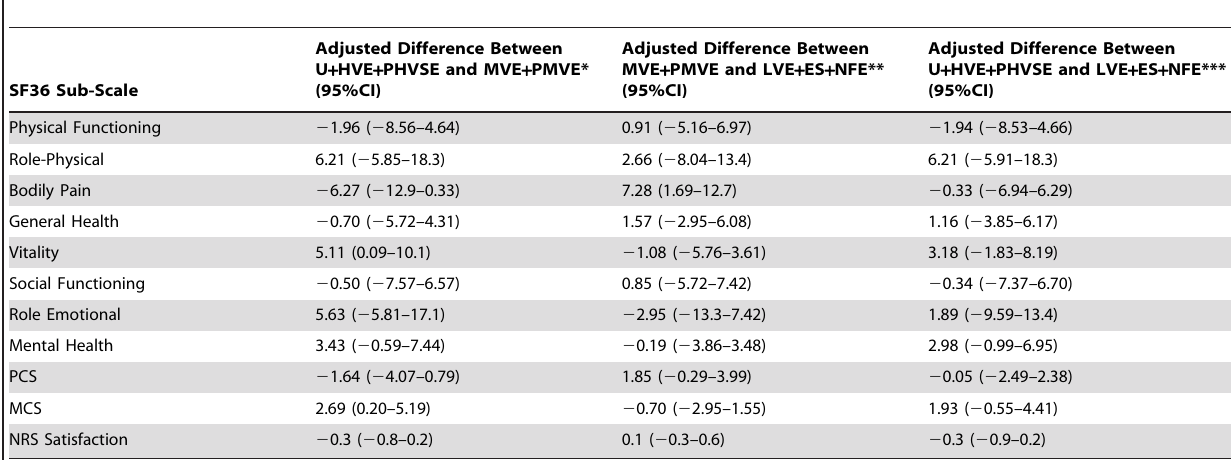
Table 8. Adjusted Difference in Improvement in Health-Related Quality of Life and Satisfaction after Hip Replacement.: A Comparison Between Patients with different Completed Levels of Schooling.